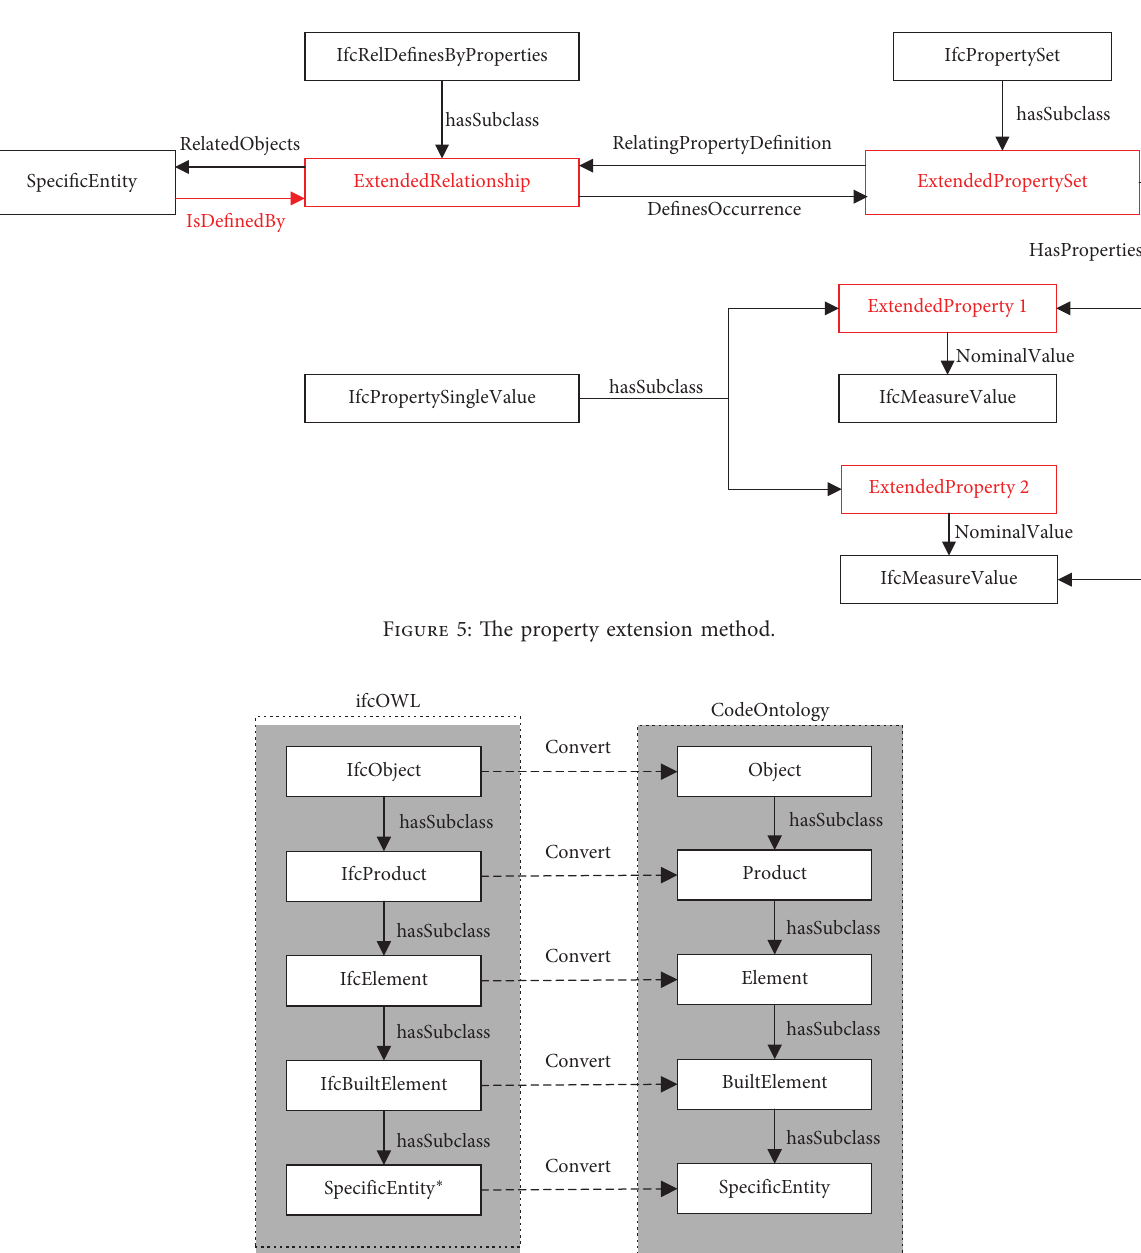
Figure 6: The entity conversion method.